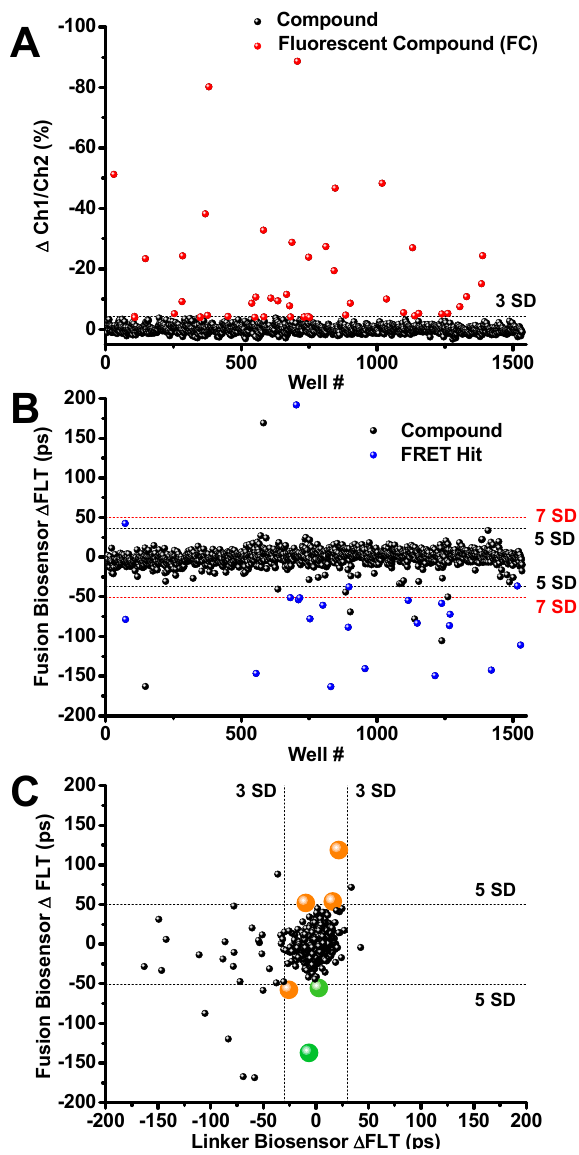
Figure 4. Library of pharmacologically active compound (LOPAC) Screen Results ( A ) Ch1/Ch2 intensity ratio flags 27 fluorescent compounds (FC; red). ( B ) Compounds that change the SERCA2a-PLB fusion biosensor FLT by ≥ 5SD were selected as Hits (blue). FCs were flagged and excluded from Hits. Two Hit thresholds are shown, 5SD and 7SD (black and red dotted lines, respectively. ( C ) Hits were further triaged by counter screening using the cell line expressing the GFP-RFP linker biosensor. Two reproducible Hits (thapsigargin and Ro 41-0960, shown in green) passed the linker biosensor test by changing its FLT by < 3SD. Both compounds are known SERCA2a e ff ectors. The remaining Hits are shown in orange. Raw lifetime screening data shown in Figure